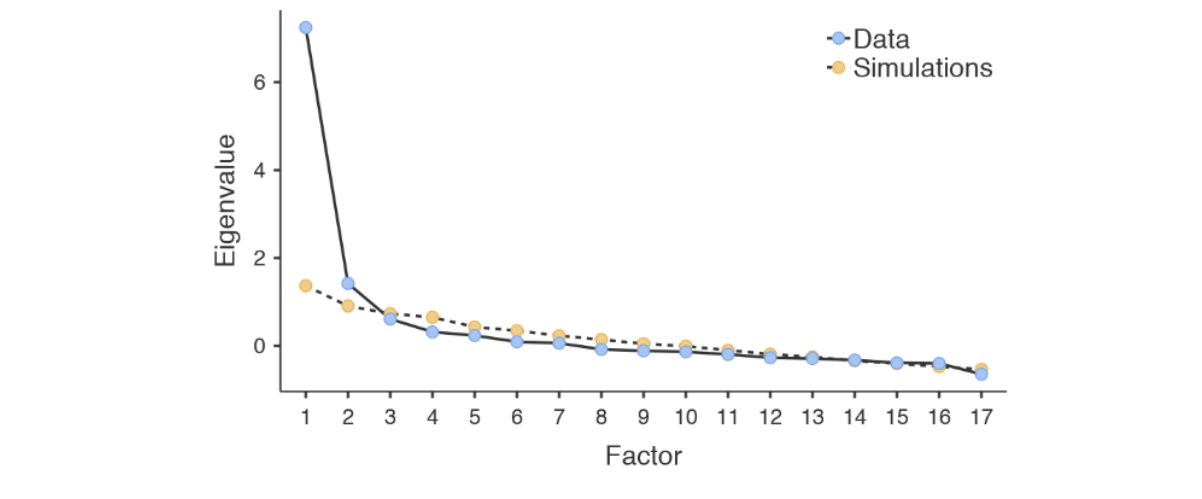
Figure 3. Parallel analysis scree plot of Virtual Therapist Alliance Scale (VTAS) items.